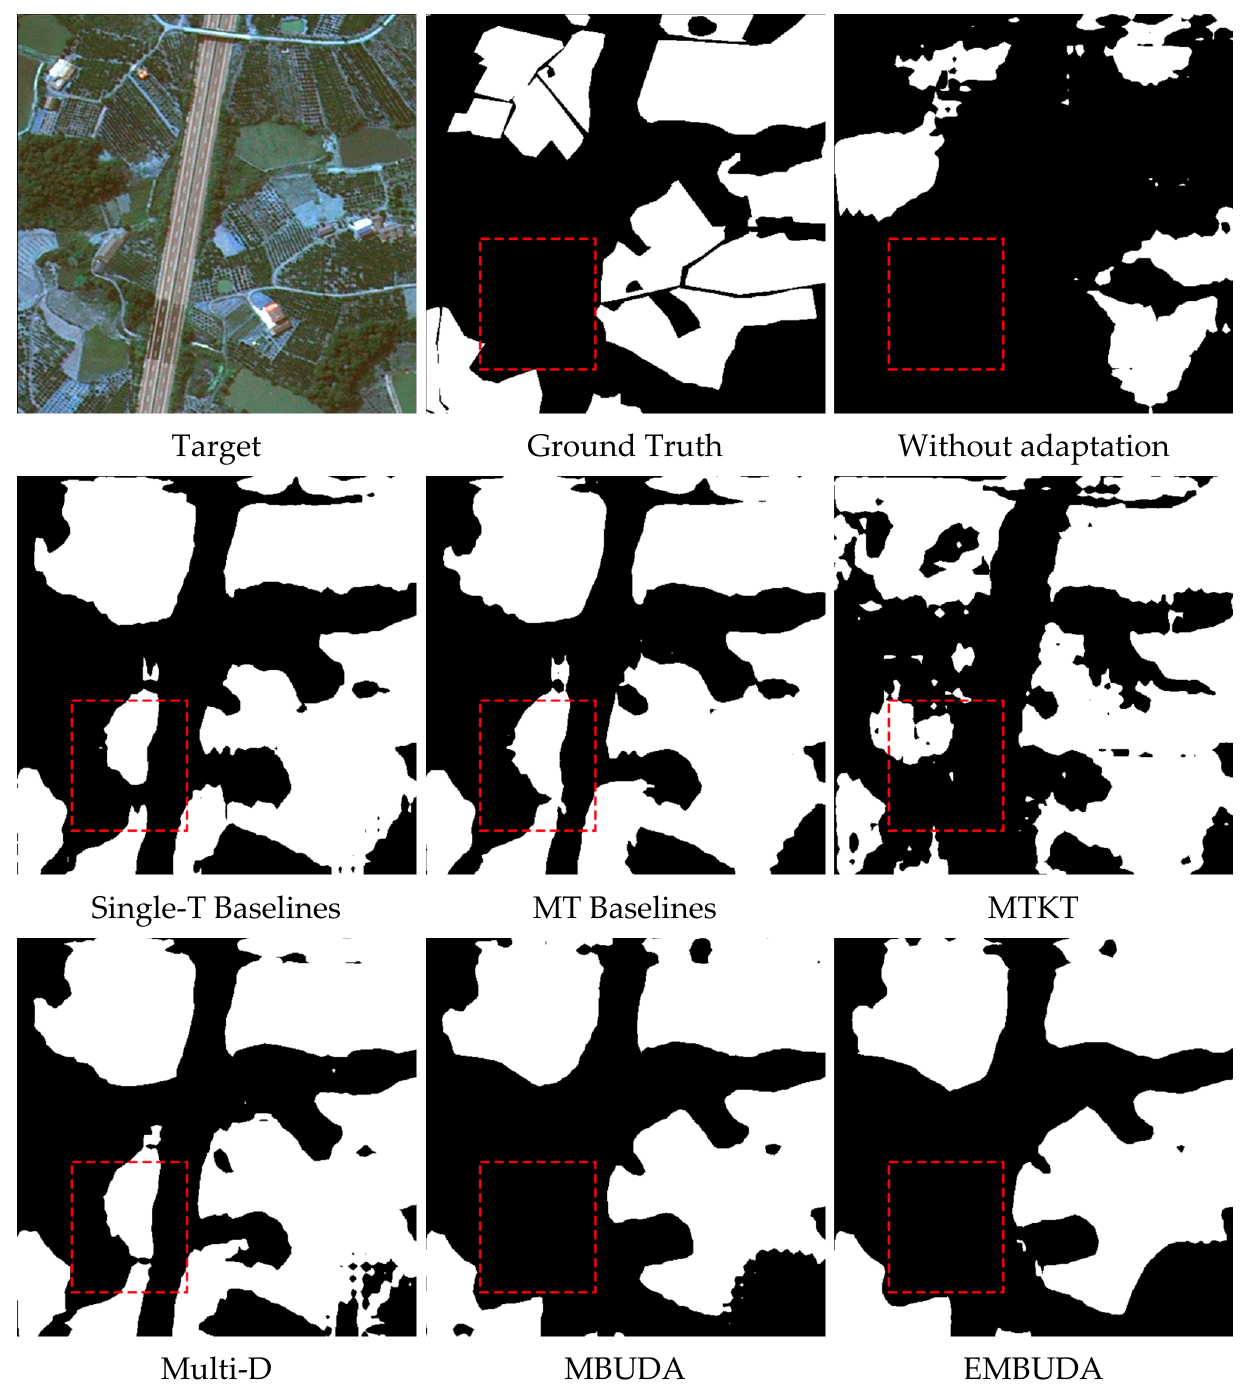
Figure A4. Outputs of orchard area segmentation in Dataset XT2 when adapting from Dataset ZG to Dataset XT1 and Dataset XT2.